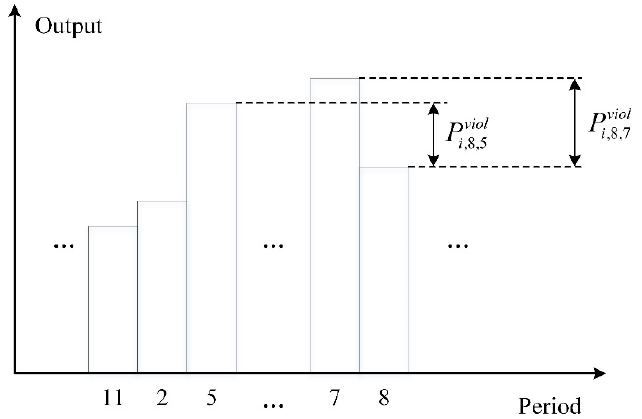
Figure 1. An example of trend violation item (TVI).